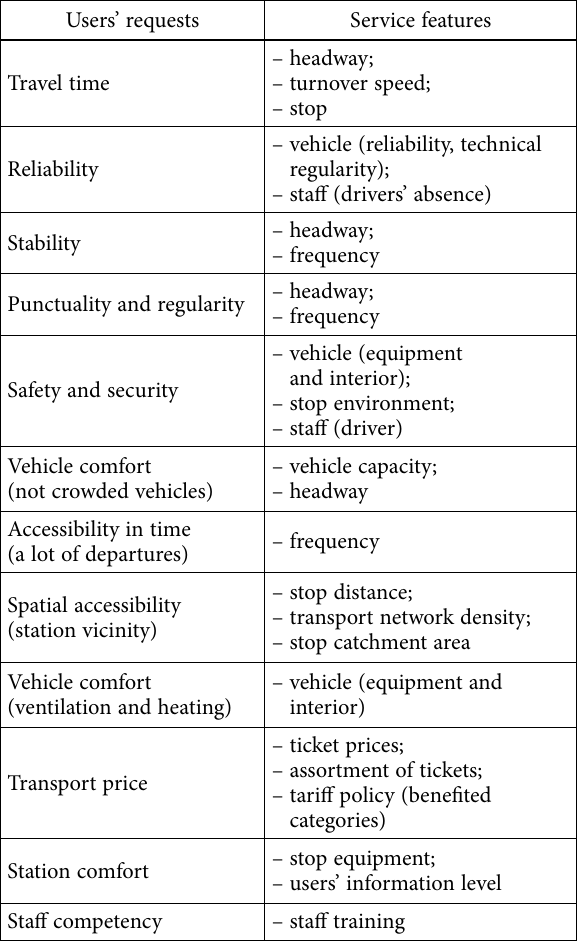
Table 2. List of users’ requests and service features Users’